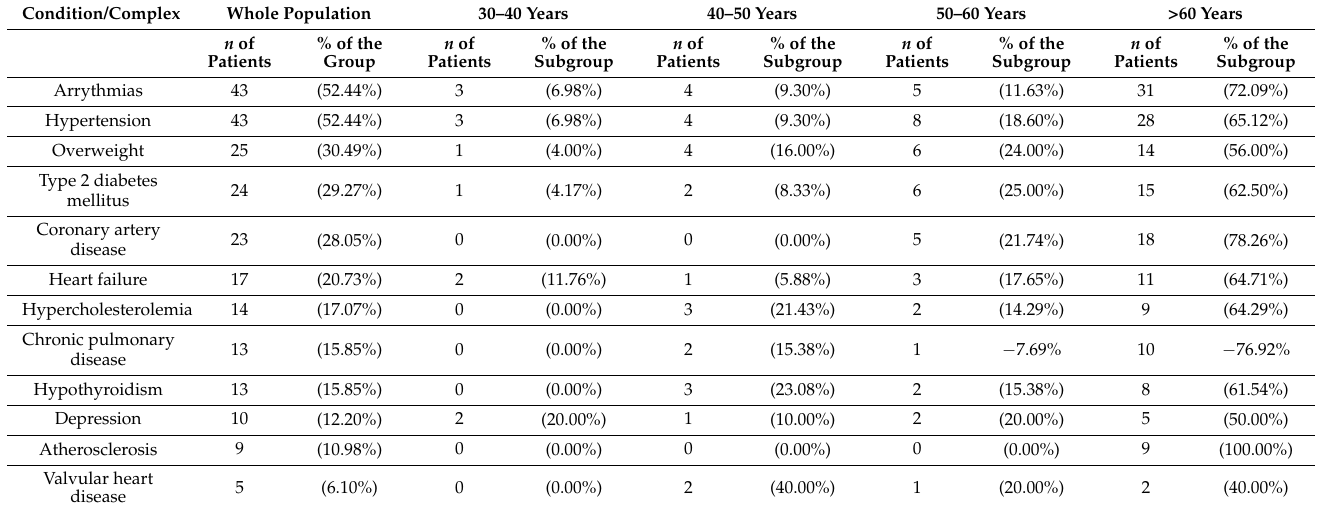
Table 1. Conditions and complexes which the patients were diagnosed with. Data are additionally stratified by age and presented as the number of patients with a percentage of the whole population or a particular subgroup.